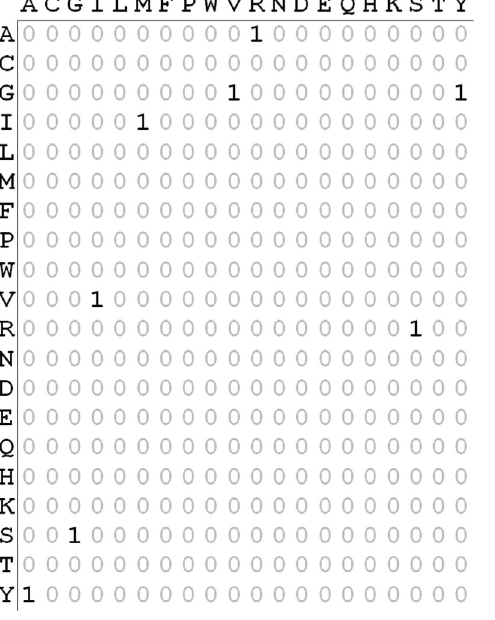
Fig 1. Amino acid adjacency matrix. The 20×20 amino acid adjacency matrix of the given β TM protein segment is shown. The matrix elements representing the frequency of the corresponding amino acid pairs in the segment are